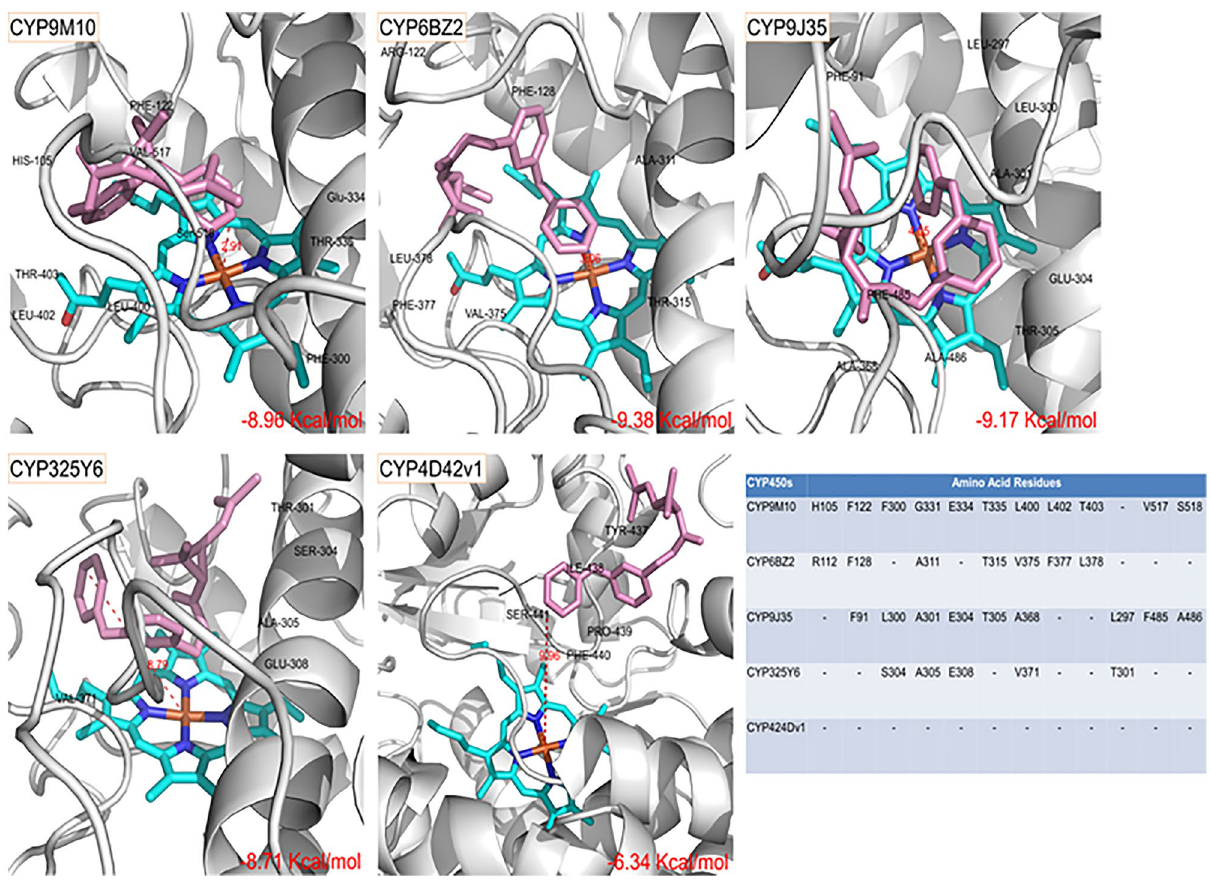
Figure 4. Docking models of permethrin in the active sites of CYP450s. The predicted binding models of permethrin in the active sites of CYP9M10, CYP6BZ2, CYP9J35, CYP325Y6, and CYP4D42v1. The partial homology model of CYP450 is represented by white helices and sheets; the Heme group is represented by cyan sticks, and the permethrin ligands are shown as pink sticks. The conserved amino acids of the catalytic pockets are labeled and